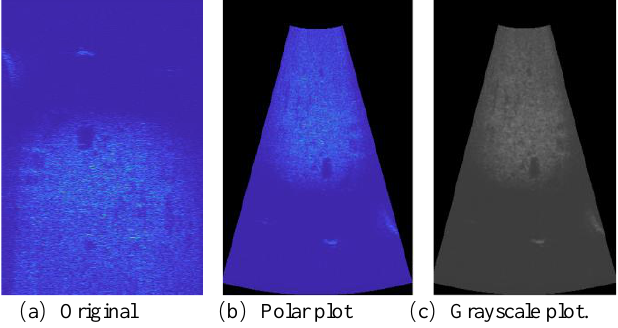
Figure 2 . Coordinate conversion rendering. 2.2.2 Image interpolatio n: After the image is converted by coordinates, the pixels are converted from the Cartesian coordinate system to the polar coordinate system, and due to the rounding operation during the conversion process, some areas are not filled and some pixels are lost. In order for the image to be closer to the original image, and the image is uniform and does not leave blanks, the blank space where the pixels are missing is interpolated using continuous uniform